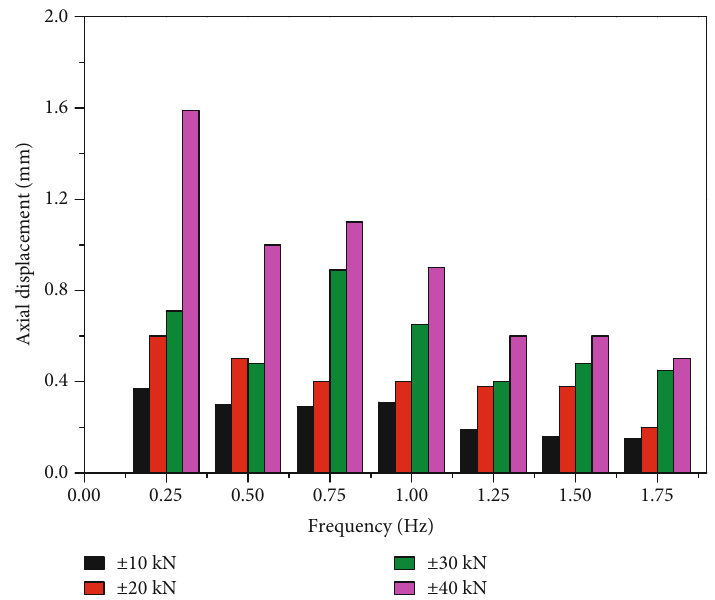
Figure 9: Variation of axial displacement with amplitude.